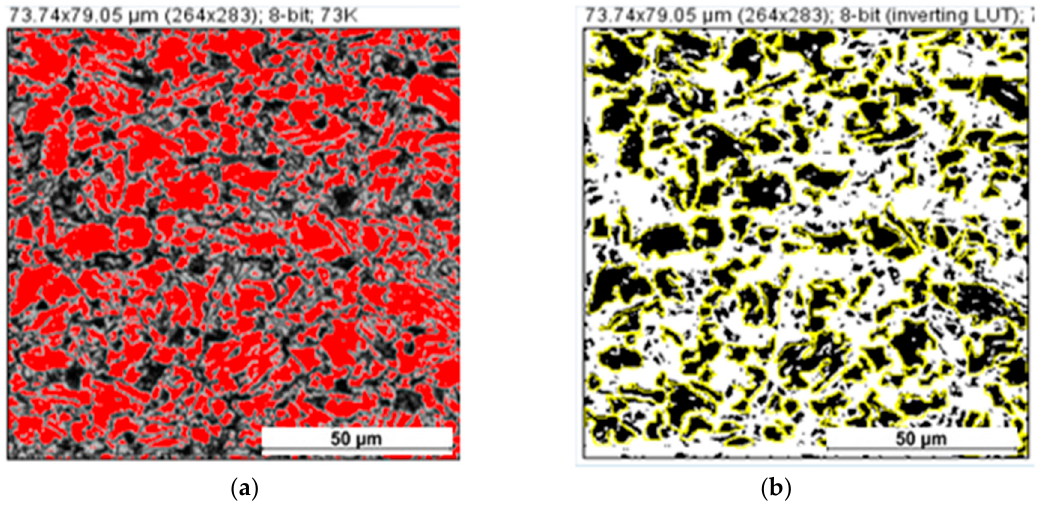
Figure 9. The microstructure of the FGHAZ region of QT steelfor the second welded condition: ( a ) calibration using Threshold ImageJ; ( b ) measurement of grain area using ImageJ 1.52p 22.